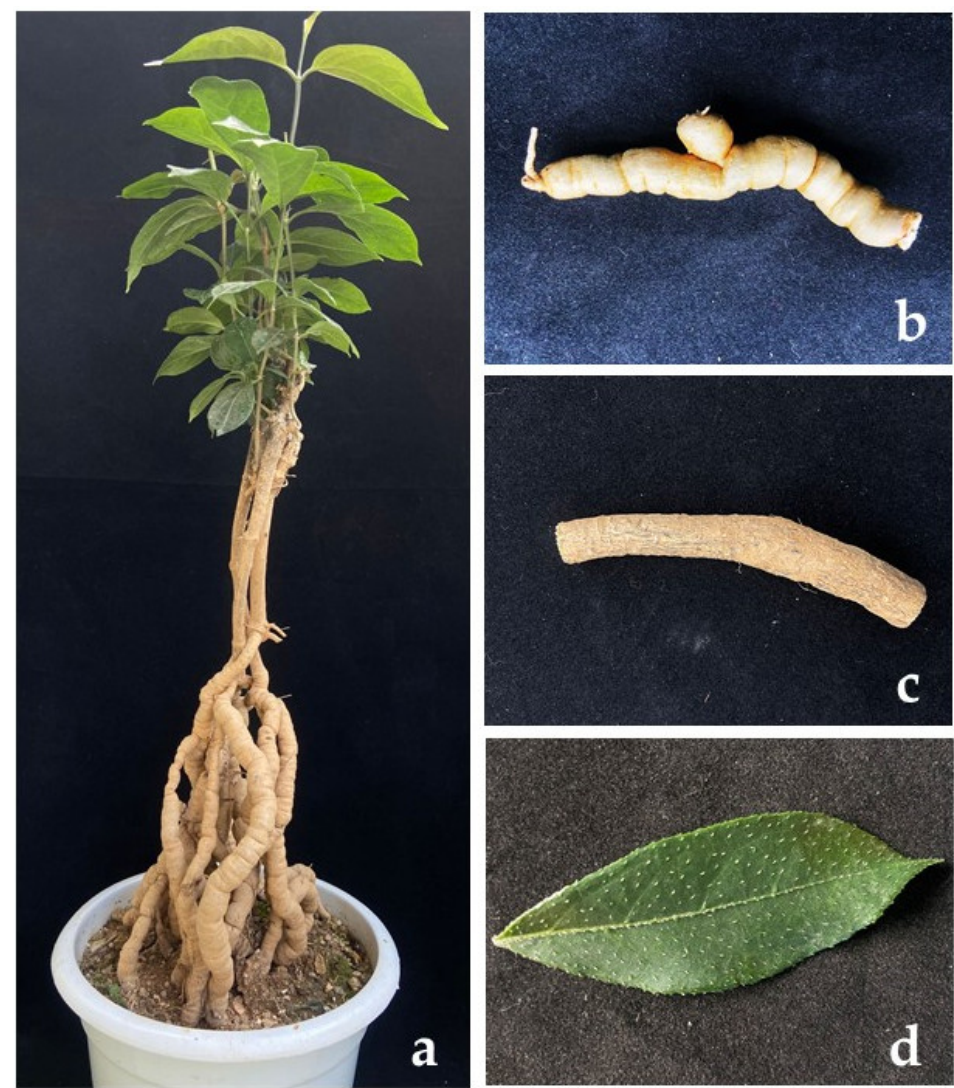
Figure 1. Morinda officinalis F.C. How. ( Rutaceae ) ( a ). The whole tree. ( b ). The root of the tree. ( c ). The stem of the tree. ( d ). The leaf of the tree.